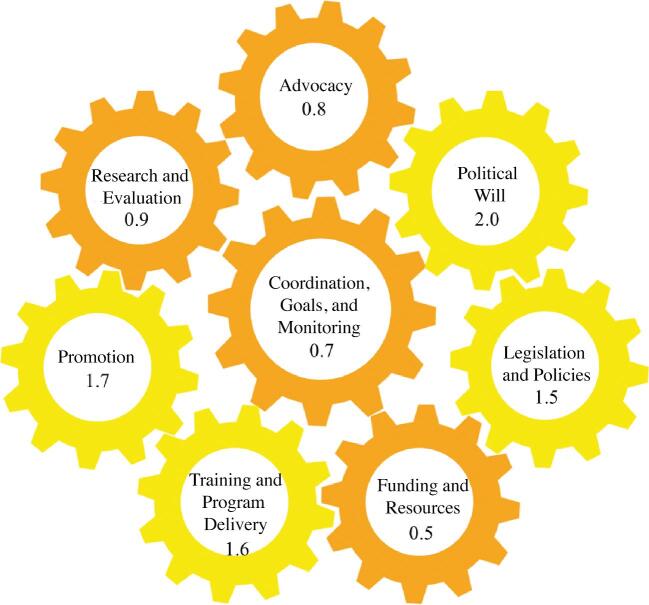
Final gear scores.